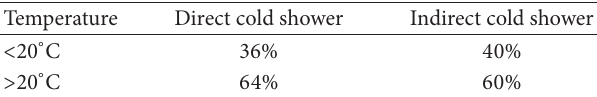
Table 1: Temperature of cold shower.